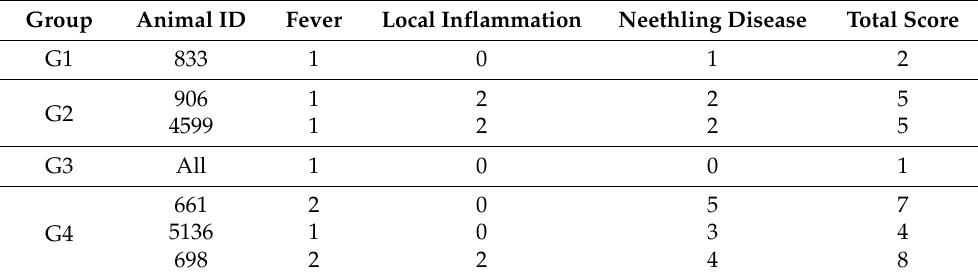
Table 4. A total cumulative scoring of animals presenting LSD-like